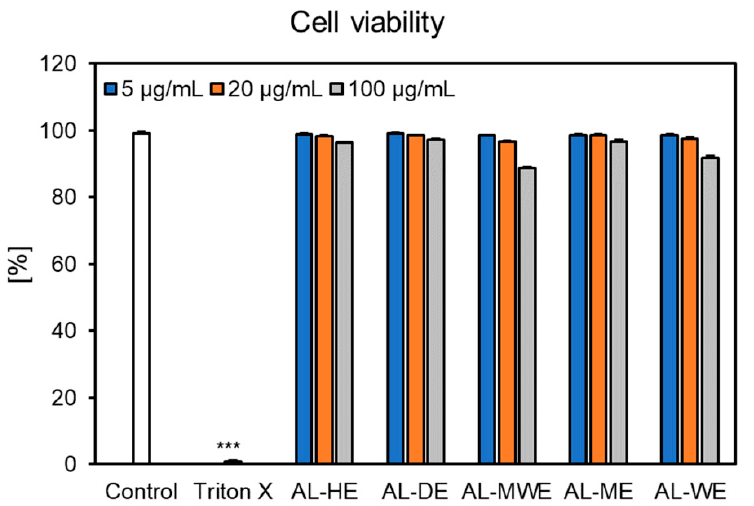
Figure 7. Neutrophil viability (%) after treatment with Artemisia campestris subsp. lednicensis extracts at concentrations of 5–100 µ g/mL and Triton X-100 (0.1%). Results are presented as the mean ± SEM of three separate experiments performed with cells isolated from six independent donors; *** p < 0.001 vs. non-stimulated control. Legend: AL-HE, A. campestris subsp. lednicensis hexane extract; AL-DE, A. campestris subsp. lednicensis dichloromethane extract; AL-ME, A. campestris subsp. lednicensis methanol extract; AL-MWE, A. campestris subsp. lednicensis 50% methanol extract; AL-WE, A. campestris subsp. lednicensis water extract.